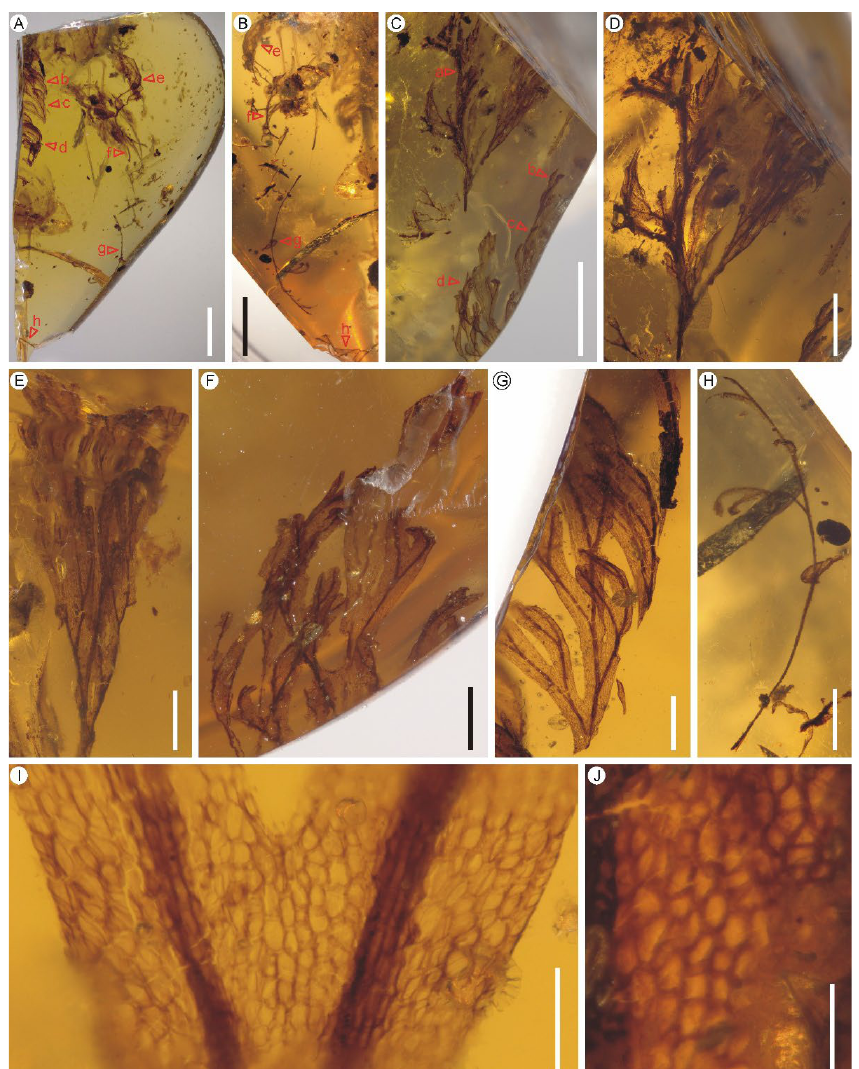
Figure 1. Hymenophyllites angustus sp. nov. from the mid-Cretaceous Kachin amber. ( A ) Top view of the amber showing seven lamina fragments. PB200744b–h. Scale bar = 5 mm. ( B ) Bottom view of the amber showing four lamina fragments. PB200744e–h. Scale bar = 5 mm. ( C ) Lateral side view of the amber showing four lamina fragments. PB200744a–d. Scale bar = 5 mm. ( D ) A tripinnatifid lamina fragment from middle portion of a lamina showing closely spaced pinnae and anadromous pinnules. Holotype PB200744a. Scale bar = 2 mm. ( E ) Portion of a pinna showing closely spaced and overlapped pinnules. Holotype PB200744a. Scale bar = 1 mm. ( F , G ) Pinnule fragments divided into simple or forked ultimate segments. PB200744d, c. Scale bars = 1 mm. ( H ) A young lamina fragment possibly from apical portion of a lamina. PB200744g. Scale bar = 2 mm. ( I ) Enlargement of lamina showing cell arrangement. PB200744c. Scale bar = 200 μm. ( J ) Laminar cells with straight cell walls. PB200744a. Scale bar = 100 μm.